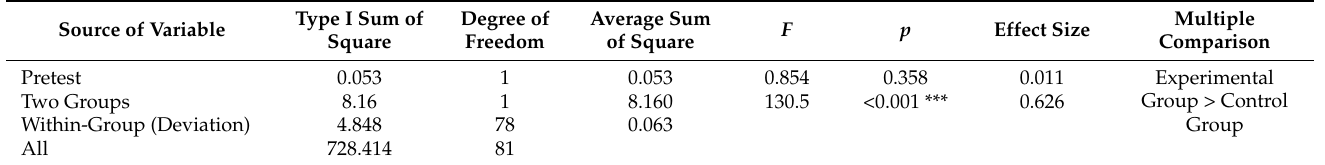
Table 2. Analysis of covariance on research subject training effectiveness (N = 81).